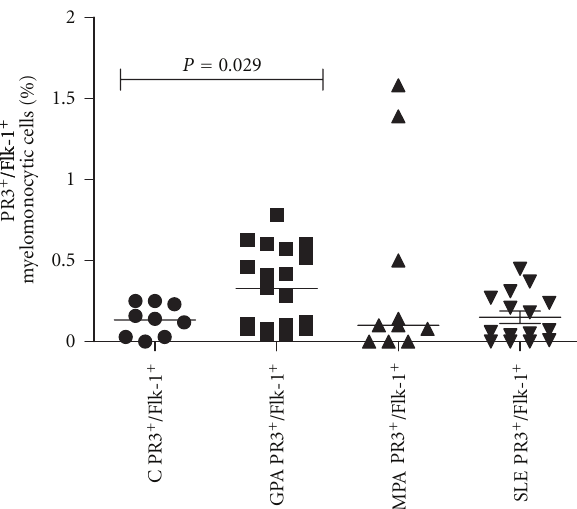
Figure 4: Percentages of PR3 + /Flk-1 + cells. In order to evaluate PR3 expression on cells belonging to the endothelial lineage, peripheral myelomonocytic cells were stained for both, PR3 and Flk-1. As for the total myelomonocytic cell population, GPA patients showed higher percentages of PR3 + /Flk-1 + cells than controls. Such di ff erences were not detected between MPA or SLE and controls (bars show